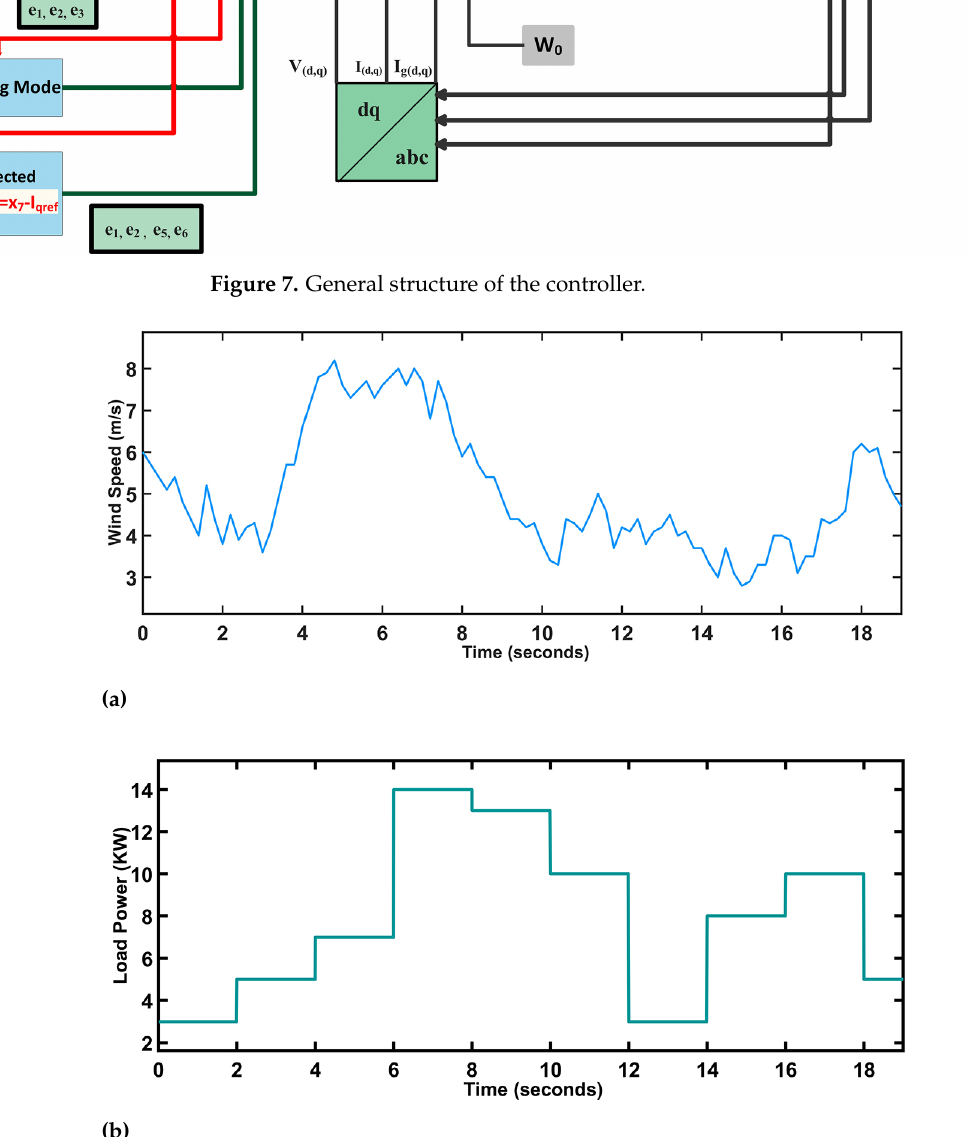
Figure 8. ( a ) Wind Speed Profile ( b ) Load Power